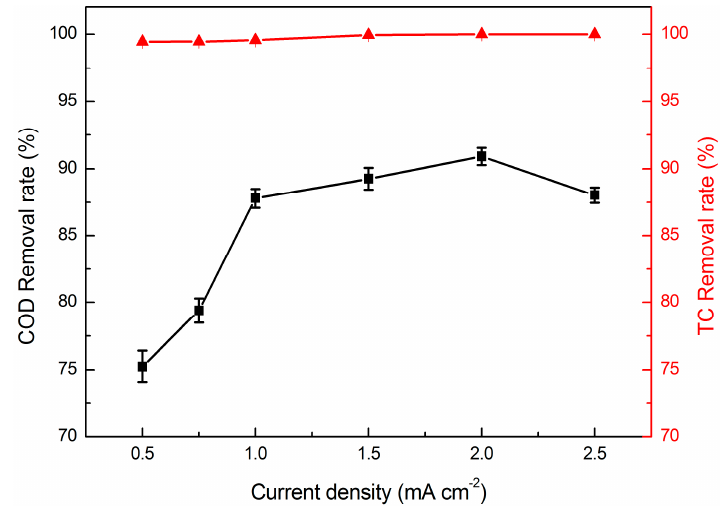
Figure 4. Effect of current density on the removal rate of TC ( ▲ ) and COD ( ■ ). ( TC = 50 mg·L − 1 , RT = 4.4 min, and T = 25 °C).